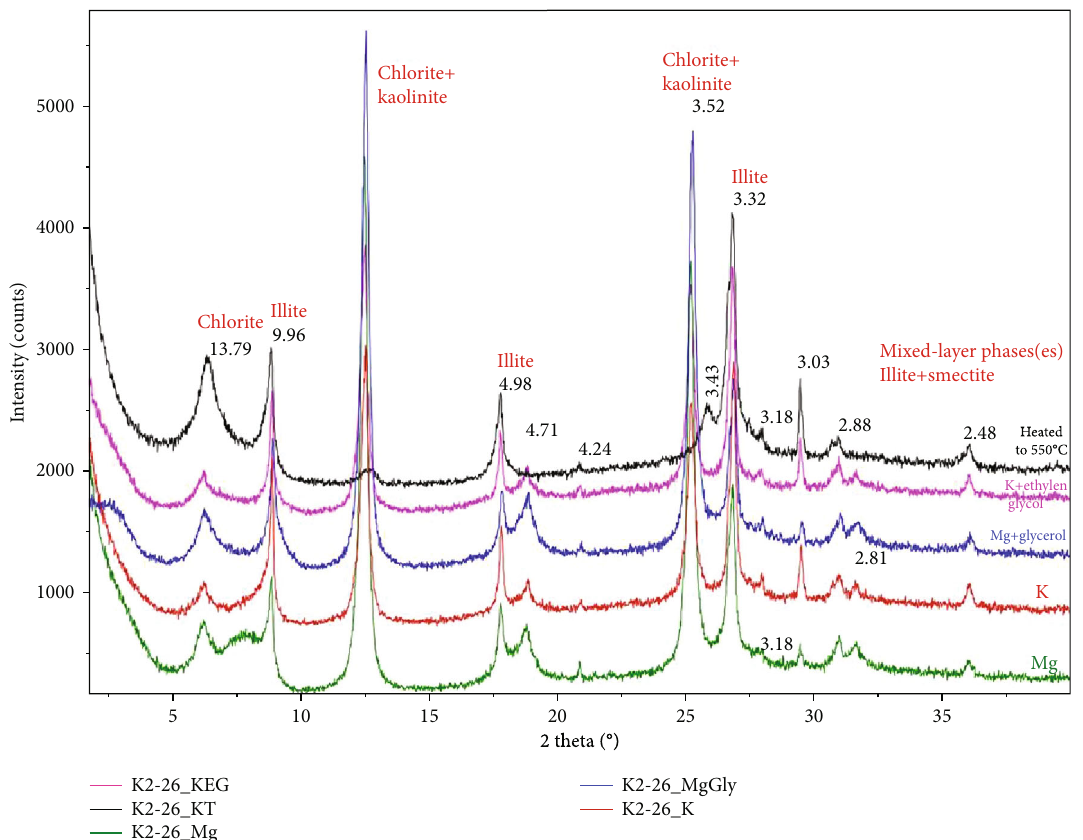
Figure 12: XRD patterns of oriented, < 2 μ m fraction samples of a characteristic sample from the Algy ő Fm, 3051.43m.